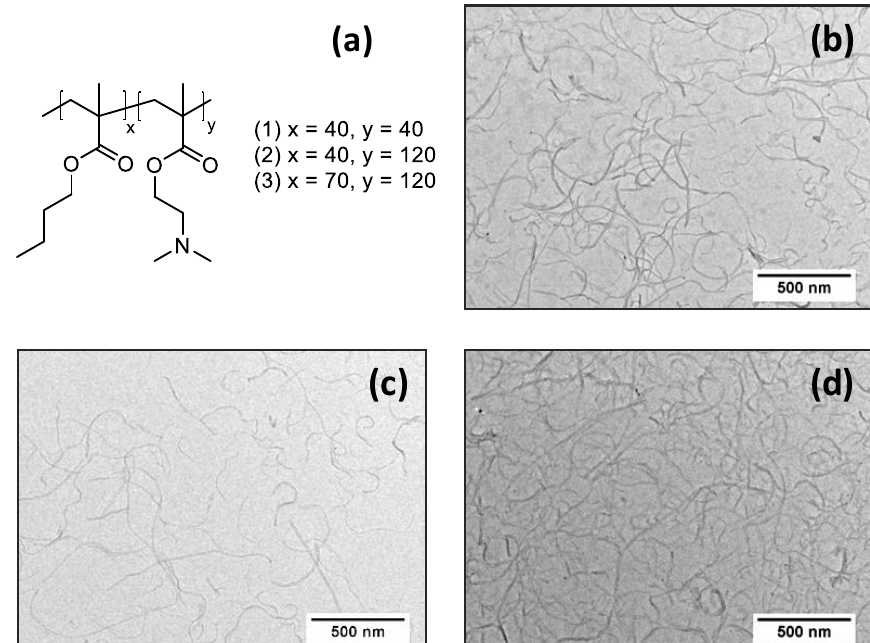
Figure 1. ( a ) The structure of P n BMA x - b -PDMAEMA y diblock copolymers; ( b-d ) TEM micrographs of the (P n BMA 40 - b -PDMAEMA 40 + MWCNT) ( b ), (P n BMA 40 - b -PDMAEMA 120 + MWCNT) ( c ), and (P n BMA 70 - b -PDMAEMA 120 + MWCNT) ( d ) dispersions. The (P n BMA x - b -PDMAEMA y + MWCNT) dispersions were prepared by ultrasonication of 1 g/L of the MWCNTs in a 5 g/L aqueous solution of the corresponding diblock copolymer at pH 3.